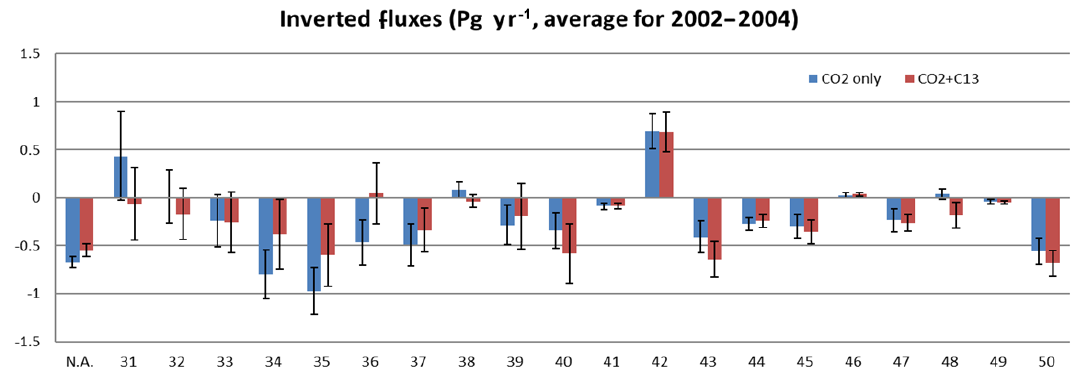
Figure 10. Comparison between inversion results with and without 13 CO 2 constraint for 21 regions of the globe for the periods of 2002–2004.